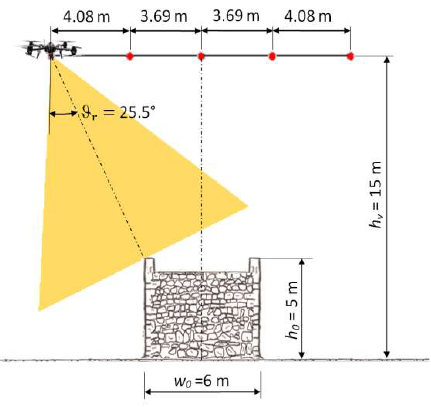
Figure 5. Gimbal rotation ϑ r around the horizontal axis parallel to the longitudinal direction in EG at h v = 15 m.